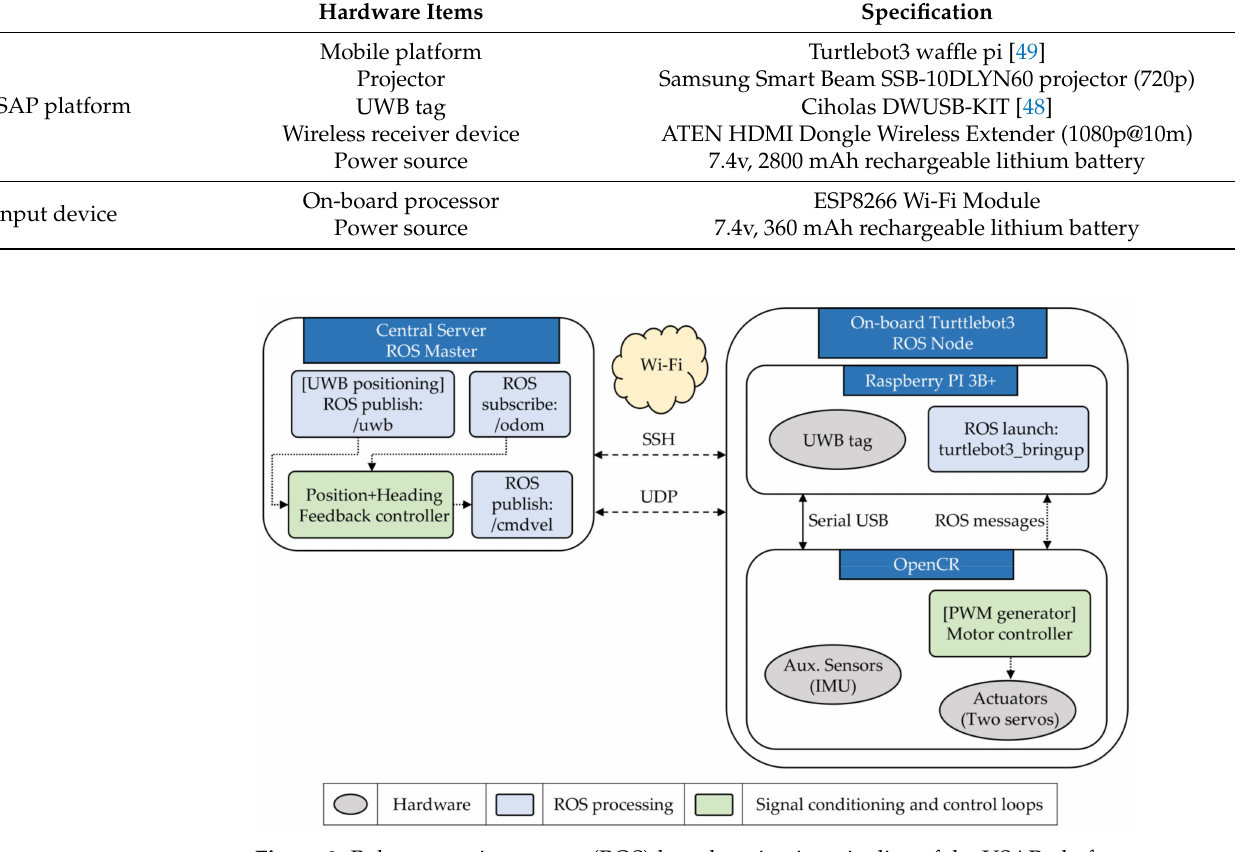
Figure 3. Robot operating system (ROS)-based navigation pipeline of the USAP